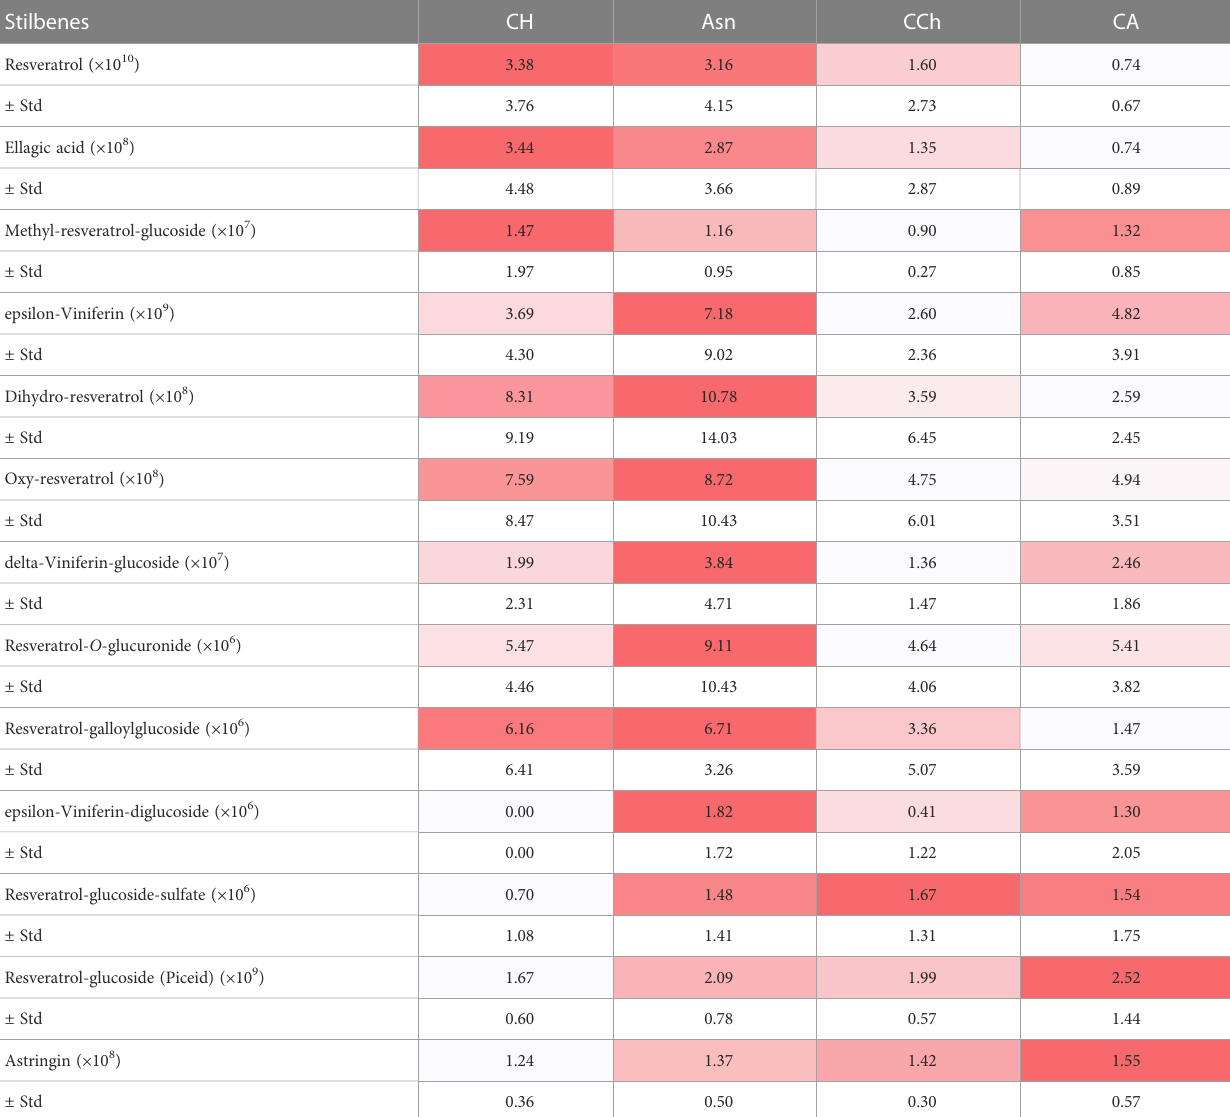
TABLE 2 Intensities of targeted stilbenes secondary metabolites in wood samples (WH, WS and WI) in asymptomatic: healthy (CH) and sodium arsenite-treated (Asn) and symptomatic: chronic form of disease (CCh) and apoplectic (CA) grapevines. Stilbenes CH